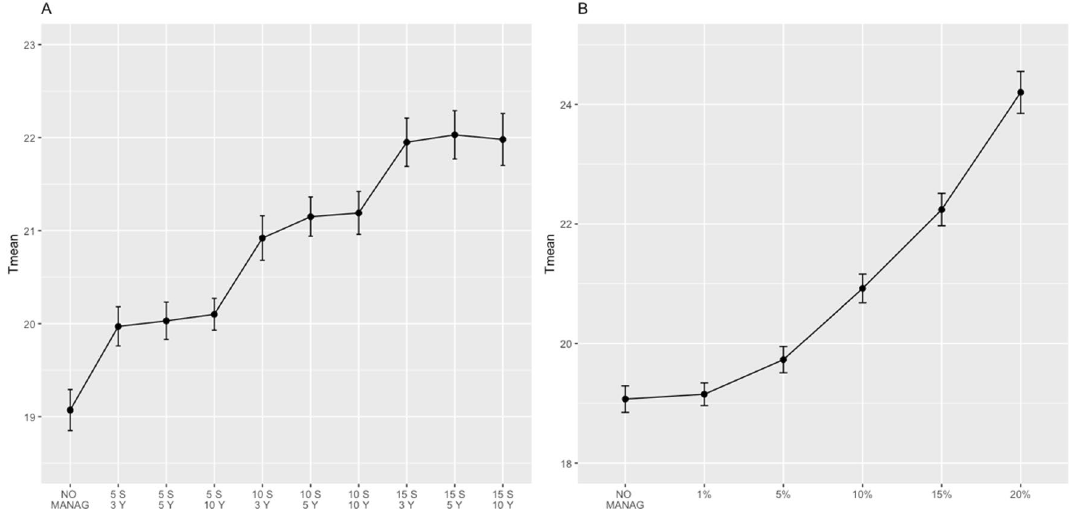
Figure 2. Effects of habitat restoration simulations in metapopulation mean time to extinction. ( A ) nine different scenarios varying the number of subpopulations managed (selecting those with higher population size: 5, 10 and 15 subpopulations) and time period of the program (3, 5 and 10 consecutive years). ( B ) using the alternative of 10 subpopulations during 3 years of management (considered of real applicability), five scenarios of management intensity were tested (1, 5, 10, 15 and 20% increase of productivity and carrying